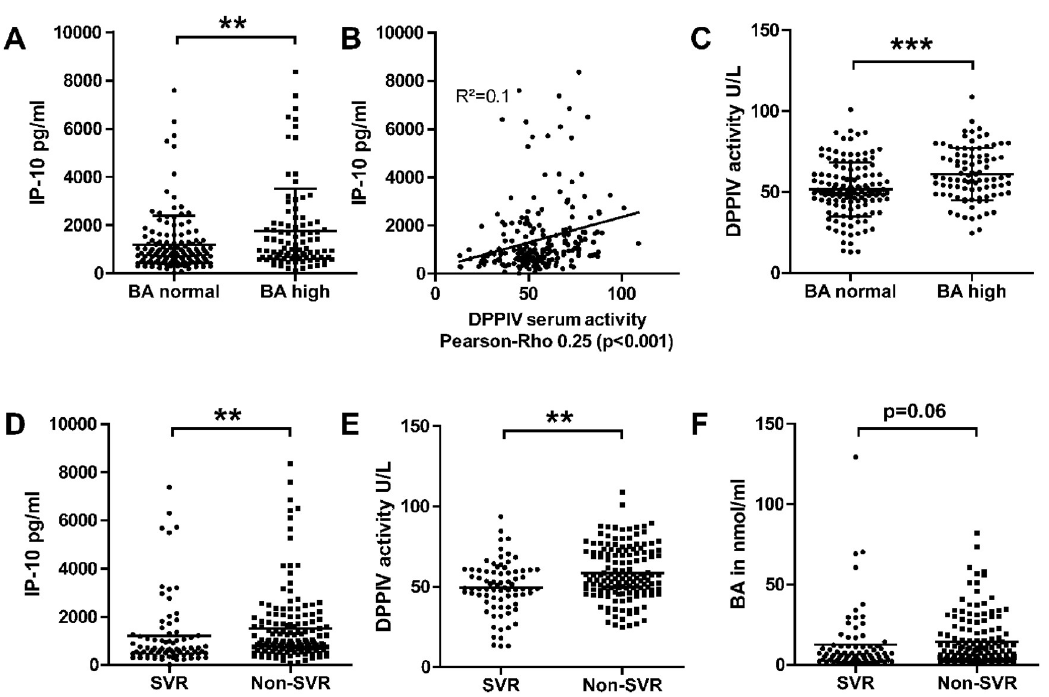
Fig 1. Serum IP-10 levels, DPPIV activity and BA levels in HCV patients (n = 229). A) Cholestatic HCV patients with serum BA > 10 μ M had higher IP-10 serum levels. Mean ± SD (Wilcoxon Mann Whitney test; �� = p < 0.01). B) Positive correlation between IP-10 serum levels and DPPIV serum activity (Pearson-Rho 0.25; p < 0.01). C) Cholestatic HCV patients had higher DPPIV serum activity. Mean ± SD (Wilcoxon Mann Whitney test; ��� = p < 0.001). D) Non-SVR patients had higher IP-10 levels (E), higher DPPIV serum activity (F) and a trend towards higher serum BA compared to HC. Mean ± SD (Wilcoxon Mann Whitney test; �� = p < 0.01).